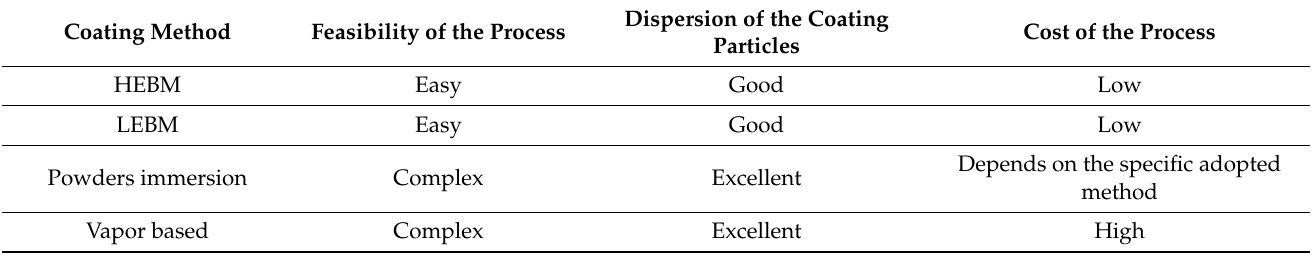
Table 1. A schematic summary of the coating methods’ characteristics.